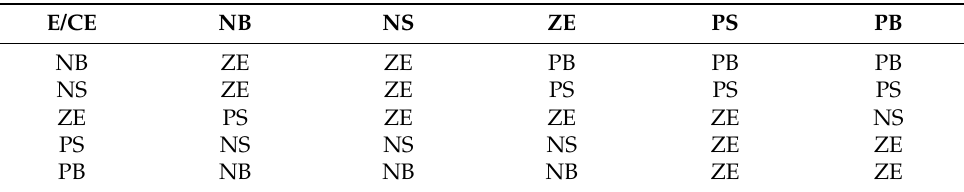
Table 2. Fuzzy rules sets.